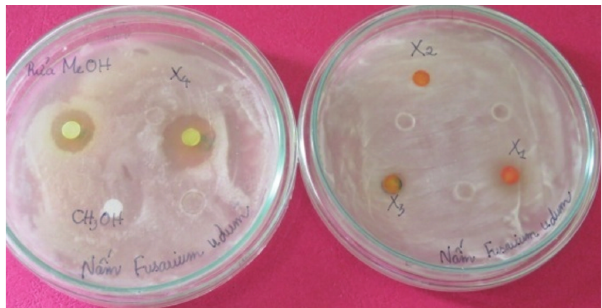
Figure 7: Activity against F. udum of recovered fractions. Faction 𝑋 𝑋 5 is to the left of 4 on the left